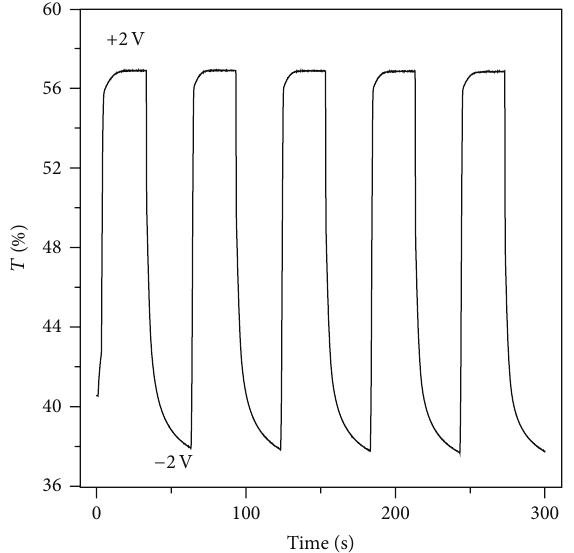
Figure 9: Time plot of UV-VIS transmittance at 700 nm during repeated switching between bleached and coloured state for a WO 3 /PE/V 2 O 5 ECD. Electrodes configuration: WO 3 /ITO/Glass as cathode and V 2 O 5 /ITO/PET as anode. Potential program: 𝐸 1 = = −2 V (versus V 𝑡 = 𝑡 = 30 s. +2 V; 𝐸 2 2 O 5 electrode); 1 2